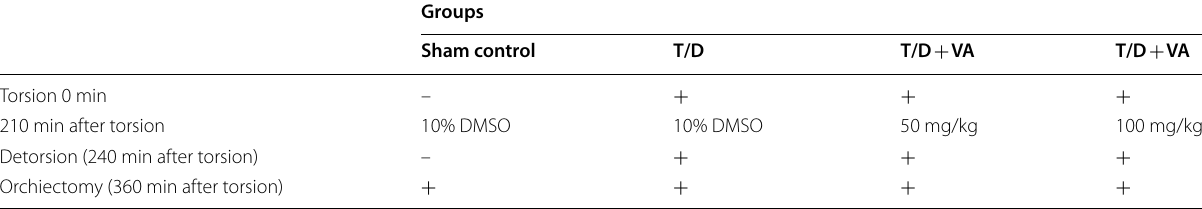
Groups Sham control T/D T/D